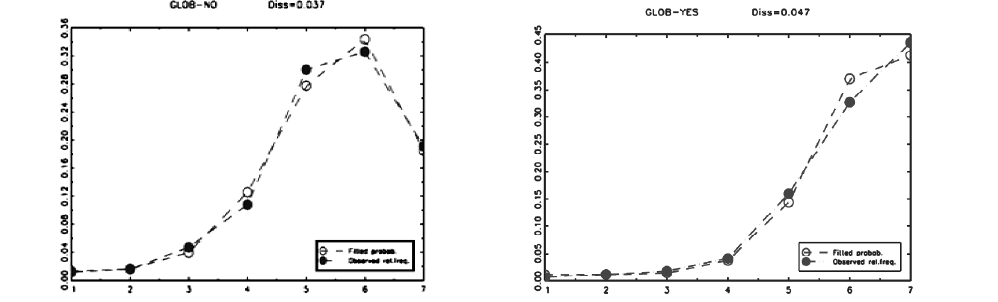
Figure 3 – Global preference: occasional users. Figure 4 – Global preference: frequent users.